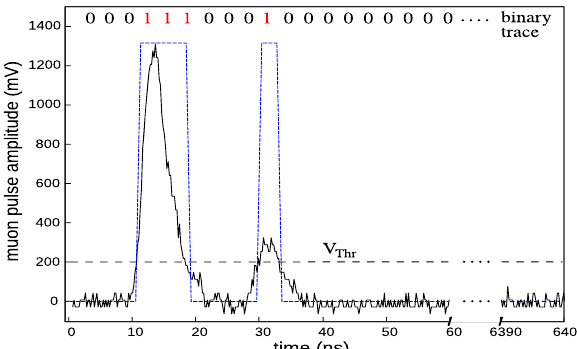
Fig. 3 The counting procedure: a muon pulse (black) is discriminated, and the discriminator signal (dashed blue) is then digitally sampled by an FPGA every 3.125ns up to 6.4 µ s. As a result, the binary trace on the top of the figure is obtained